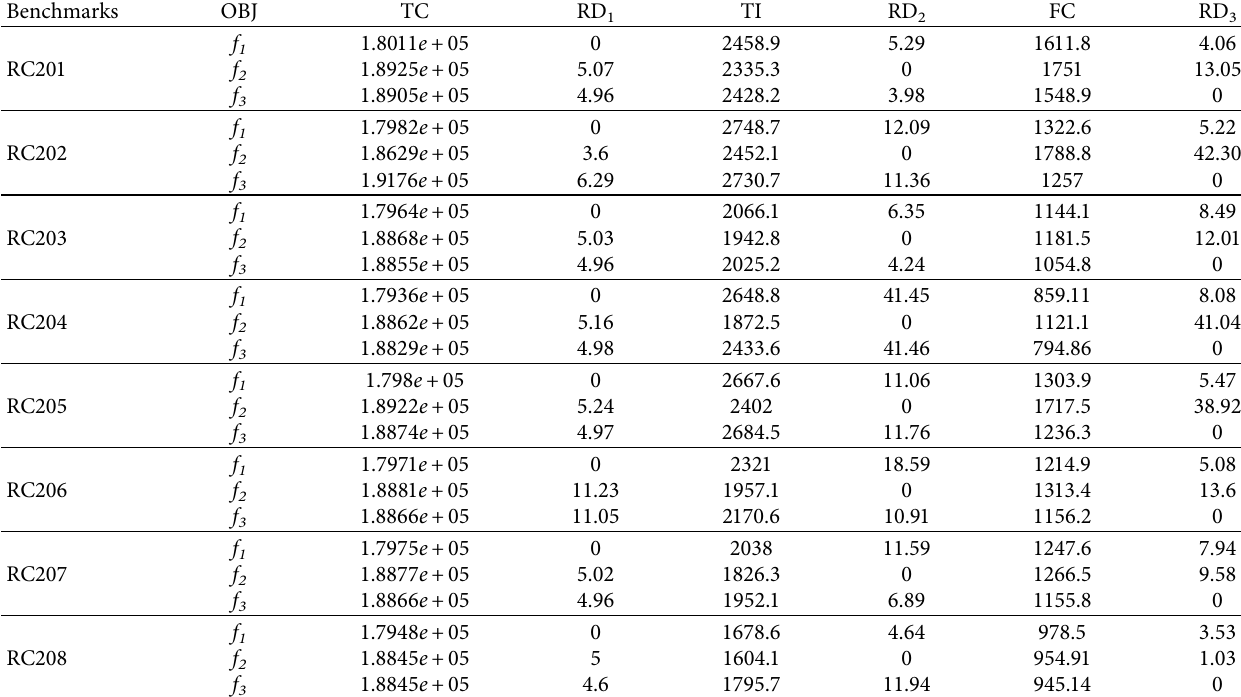
Table 9: The result of the three optimal objectives.